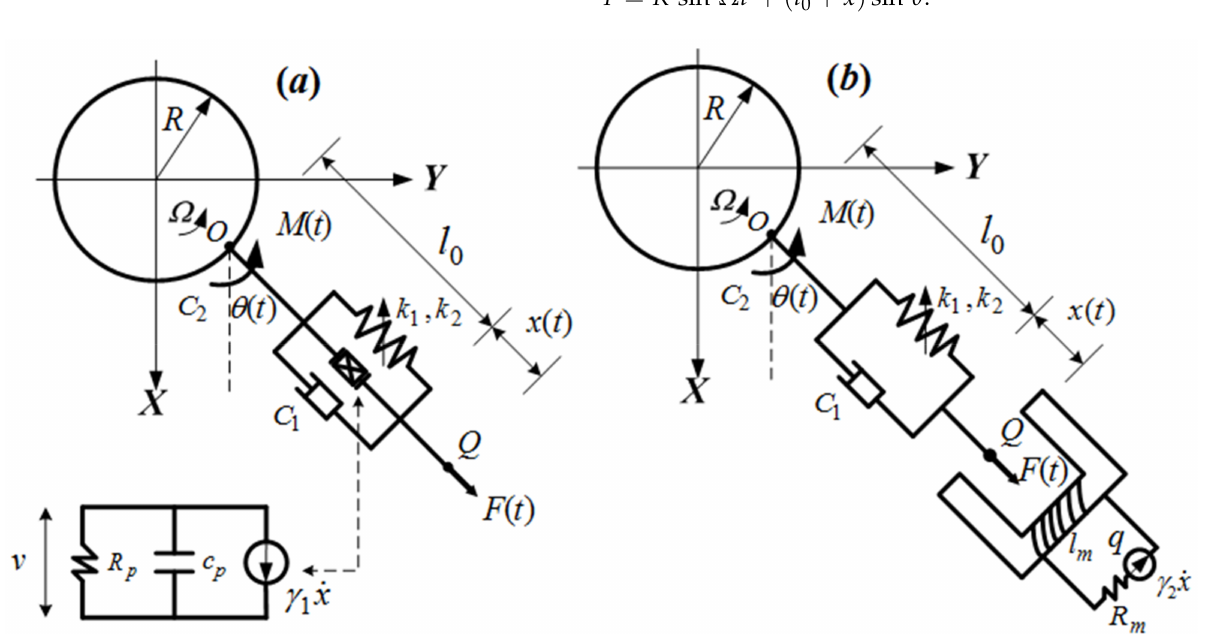
Figure 1. Two dynamical models: ( a ) a damped spring with a piezoelectric device, ( b ) a damped spring with an electromag- netic